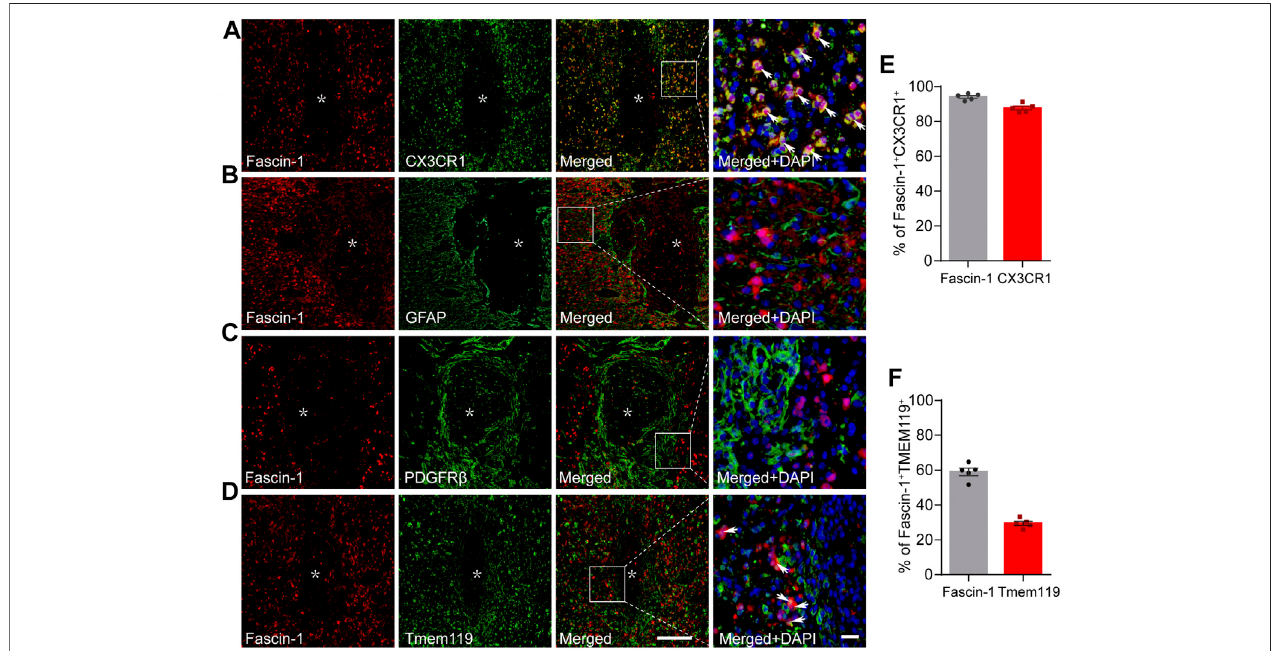
FIGURE 2 | Fascin-1 is speci fi cally expressed in CX3CR1 + activated microglia but not in GFAP + astrocytes or PDGFR β + epicenter-located pericytes at 14 days after SCI. (A) Representative immuno fl uorescence images of Fascin-1 (Red) and CX3CR1 (Green). Colocalization of the proteins is shown in yellow. Nuclear staining (DAPI)isshowninblue,and whitearrowheads indicate thecolocalizationobservedwitha × 40objectivelens. (B) Representative immuno fl uorescenceimagesofFascin- 1(Red),GFAP(Green)andDAPI(Blue)showingnoapparentcolocalizationofstaining. (C) Representativeimmuno fl uorescenceimagesofFascin-1(Red),PDGFR β (Green) and DAPI (Blue) showing no apparent colocalization of staining. The asterisks indicate the lesion epicenter. Scale bars: low magni fi cation, 200 μ m; higher magni fi cation,20 μ m. (D) Representativeimmuno fl uorescenceimagesofFascin-1(Red)andTmem119(Green).Arrowheadsindicatethecolocalizationobservedwitha × 40 objective lens. (E) Percentage of Fascin-1 + CX3CR1 + cells relative to the total number of Fasicn-1 + or CX3CR1 + cells in the injured spinal cord. (F) Percentage of Fascin-1 + Tmem119 + cells relative to the total number of Fasicn-1 + or Tmem119 + cells in the injured spinal cord. The data are presented as the mean ± SEM ( n (cid:2) 5 independent